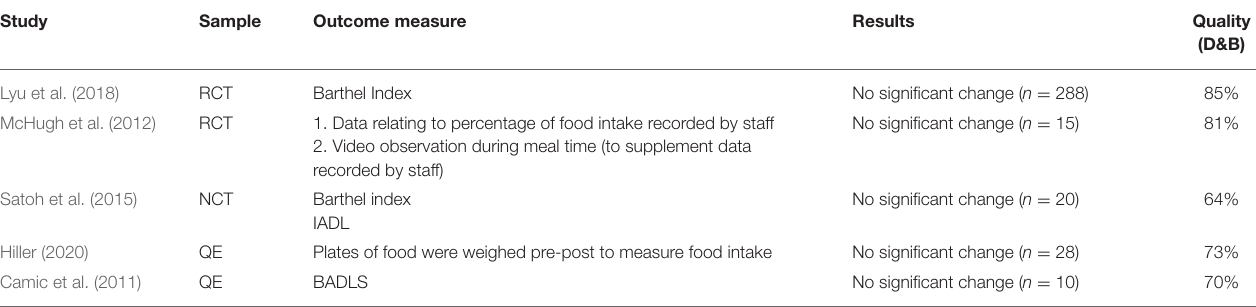
TABLE 7 | Overview of results of activities of daily living